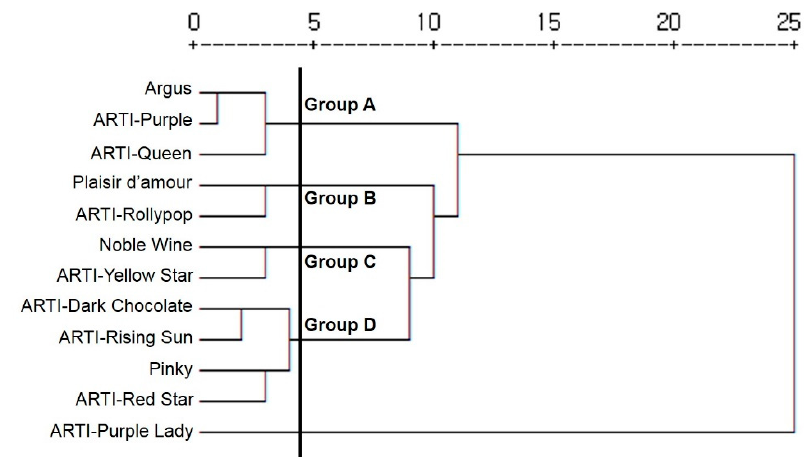
Figure 4. Dendrogram from cluster analysis of volatile components of the 12 chrysanthemum cultivars using the average linkage clustering method.